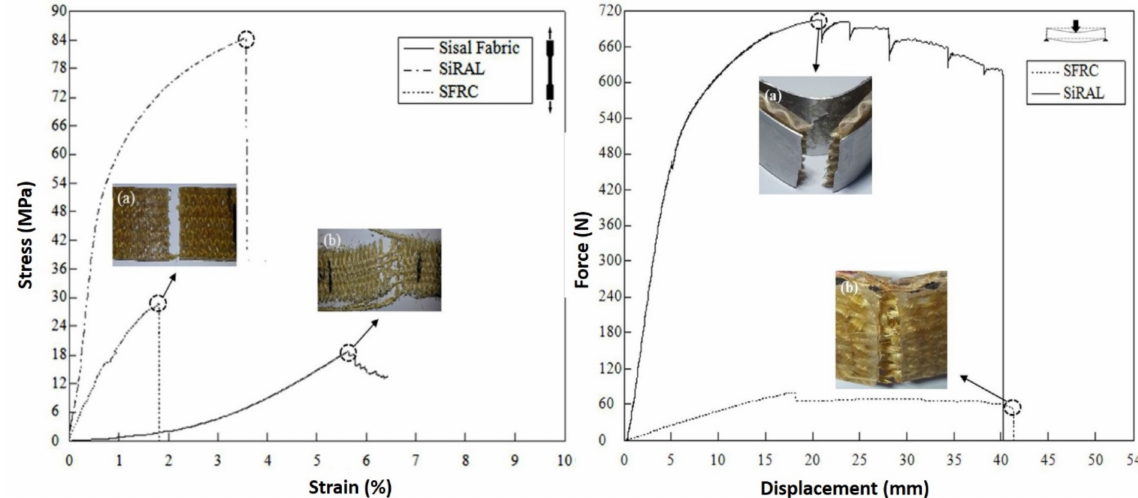
Figure 11. The ( a ) Tensile stress–strain curve and failure mode and ( b ) Flexural behavior and failure mode of sisal fabric, SFRC and SiRAL. Reproduced from